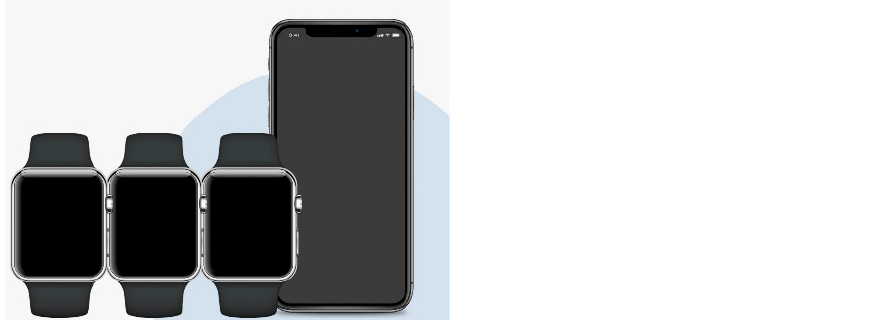
Figure 4. Representation of the NetMD system, with a mobile phone with three smartwatches de- vices.